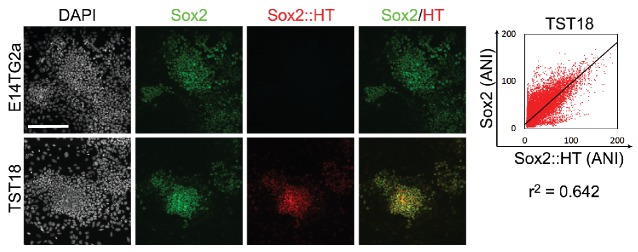
Imaging of E14Tg2a and TST18 ESCs for SOX2 by immunofluorescence (green) and of Sox2::HT fluorescence (red); DAPI is grey.Scale bar, 100 μm. Trend line was plotted between Sox2 and Sox2::HT average nuclear intensity (ANI) distributions of TST18 cells. Correlation coefficient (PMCC, r2) is indicated for the trend line.